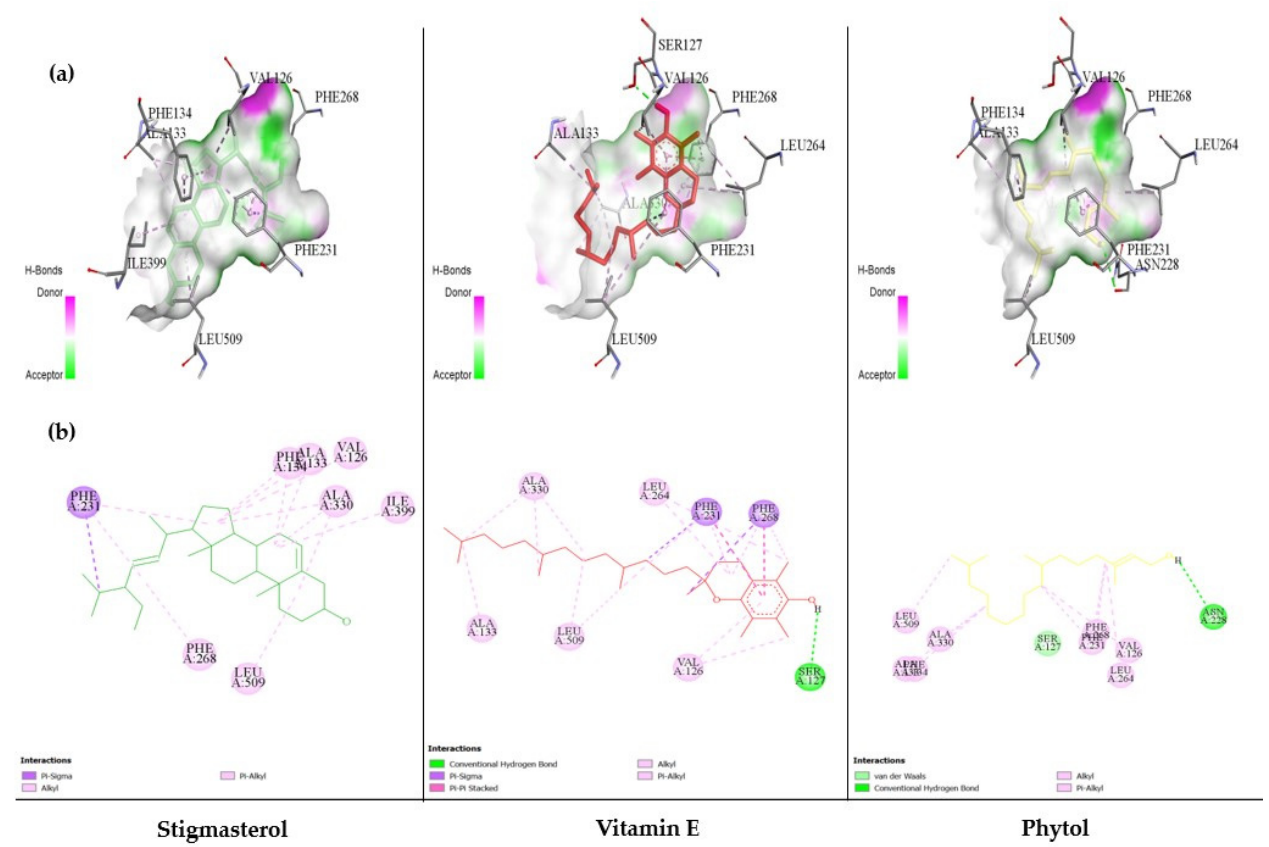
Figure 10. The results of the molecular docking study of CYP1B1 (3PM0) are represented by the 3D diagrams of interaction between each phytochemical and 3PM0 ( a ) and by the 2D diagrams of phytochemical–receptor interactions ( b ).